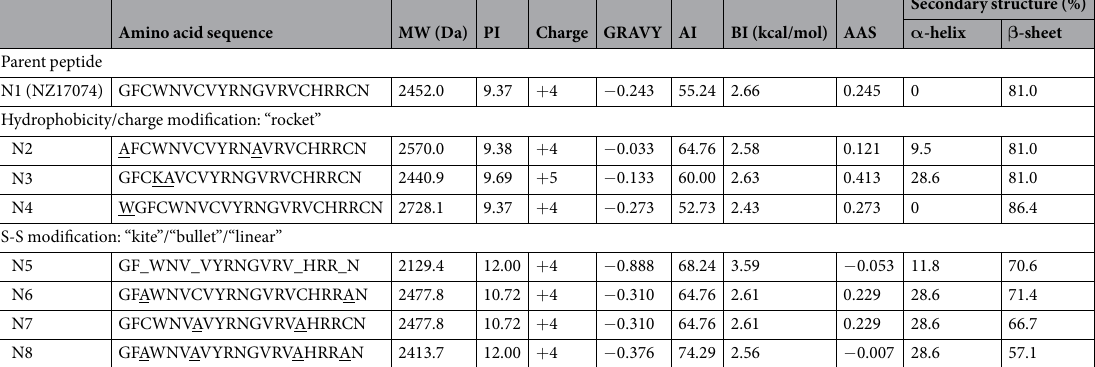
Table 1. Sequences and physicochemical properties of N1 and its analogues. Note: MW: molecular weight; PI: isoelectric point; GRAVY: grand average of hydropathicity; underlined residues: the modified residues. AI: aliphatic index; BI: Boman index; AAS: antibacterial activity score; S-S: disulfide bonds. N1, N2, N3 and N4: the “rocket” analogues with two disulfide bonds of Cys3-20 and Cys7-16; N6: the “kite” analogue with one disulfide bond of Cys7-16; N7: the “bullet” analogue with one disulfide bond of Cys3-20; N5 and N8: the other analogues without disulfide bonds.